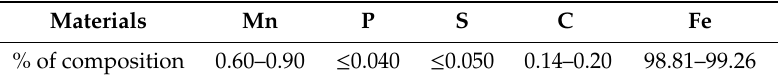
Table 2. Chemical composition of AISI 1018.